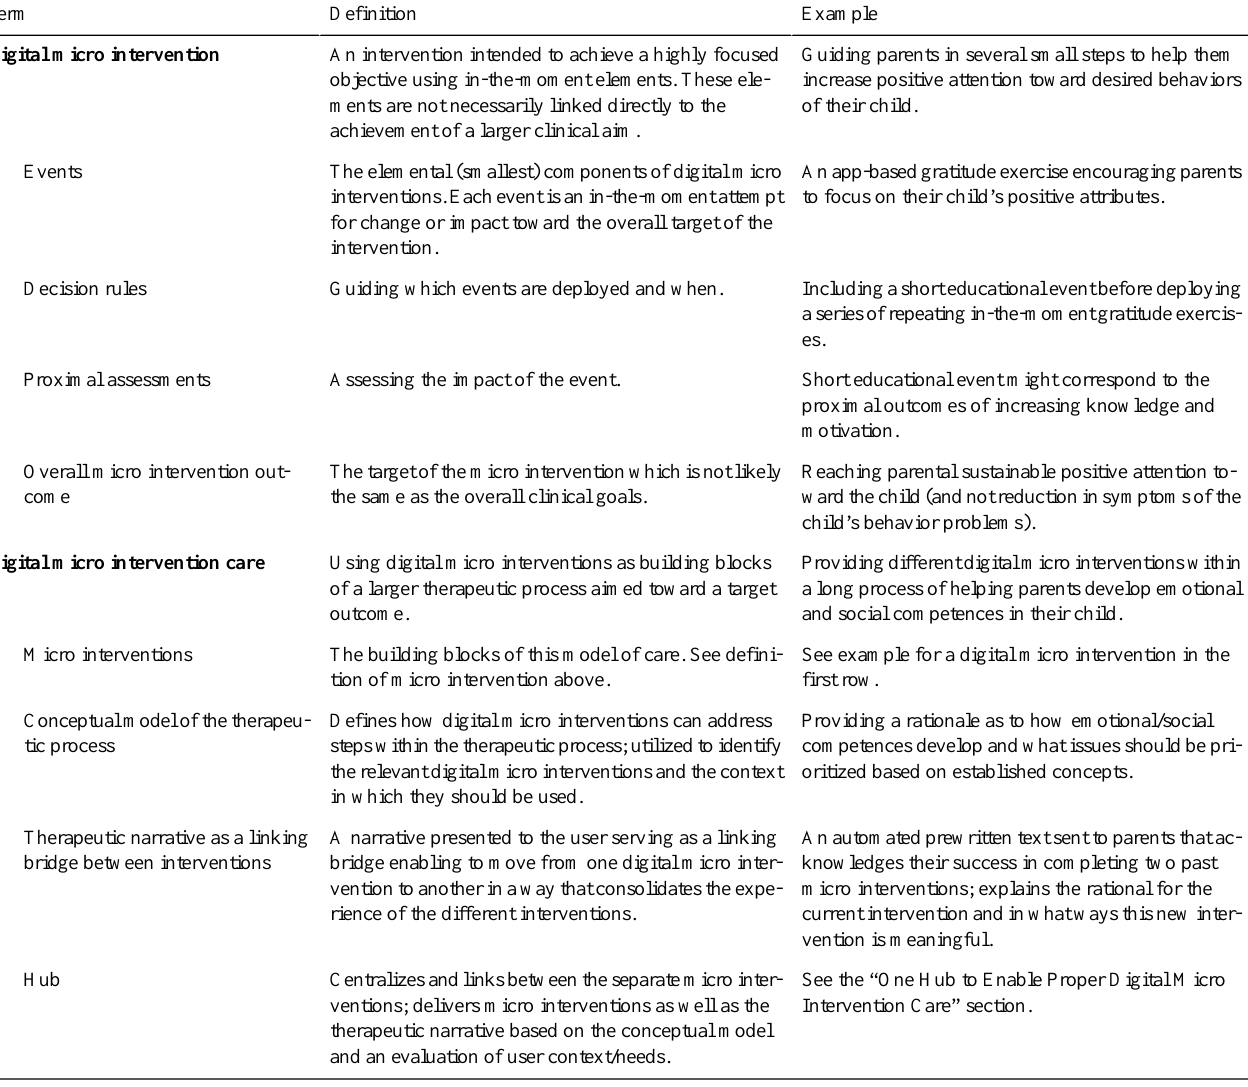
Table 1. Key terms described within the paper.